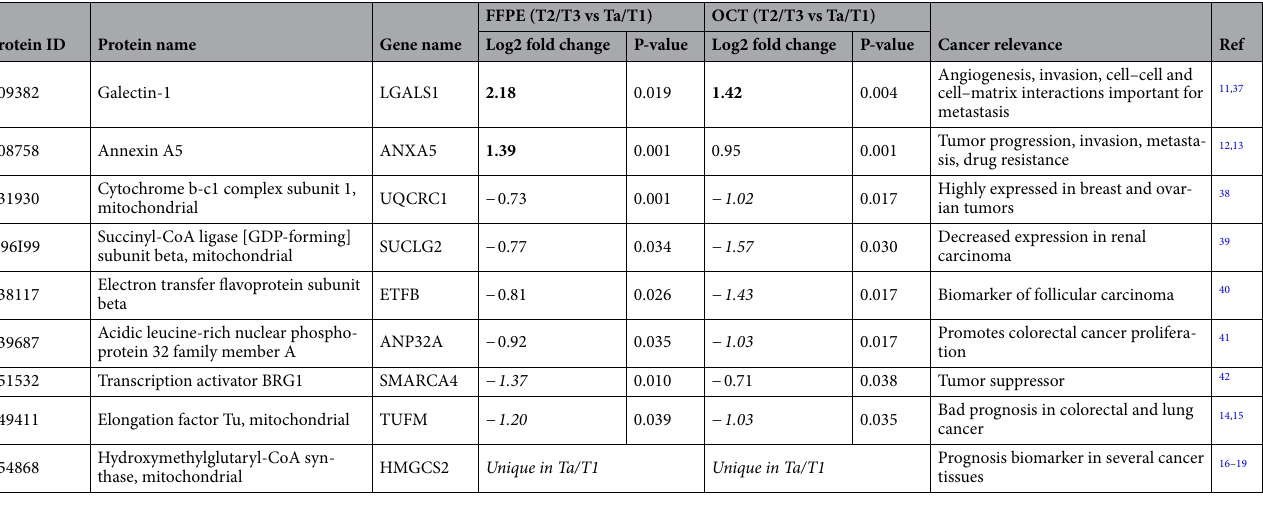
Table 3. Differentially expressed proteins and unique proteins commonly quantified in FFPE and OCT preserved samples (T2/T3 vs Ta/T1) and their relevance in cancer research. Deregulated proteins are emphasised (bold—upregulated,